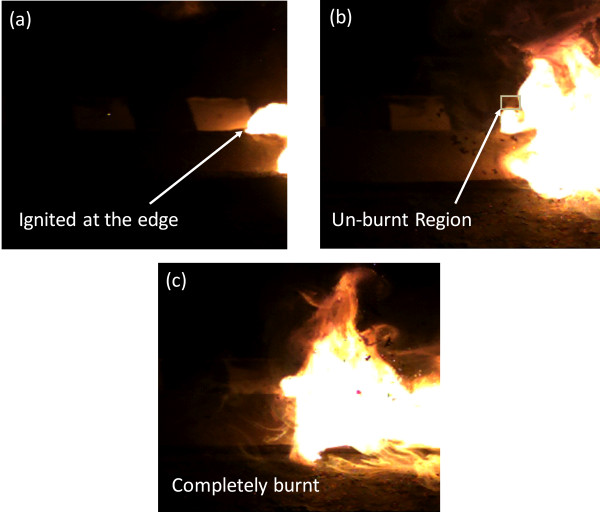
Substrate subjected to the novel process of ultra-rapid biofilm removal. The time arrival record of the flame front at different positions was determined using a high speed camera over a distance of 6 cm. (a) Initiation of the ignition at the edge of the coupon (time t = 0 ms) (b) The coupon with a small un-burnt region (time t = 30 ms) and (c) Surface of the coupon completely burnt (time t = 60 ms).